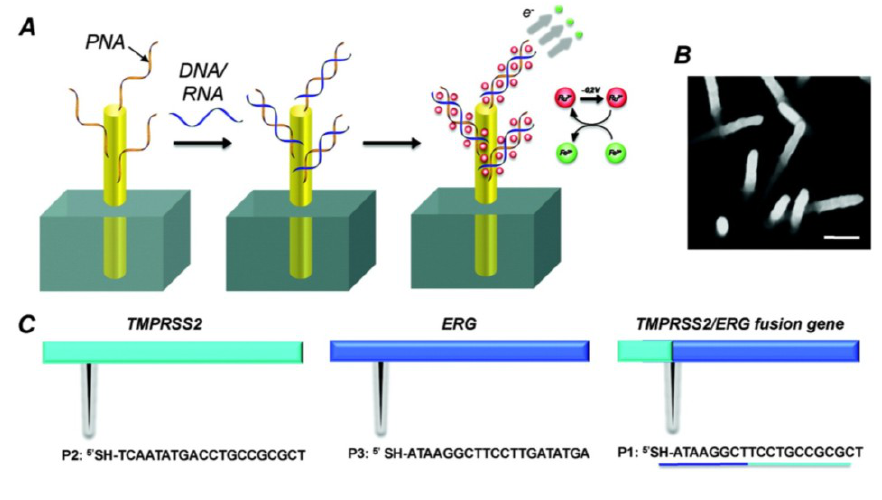
Figure 10. ( A ) Schematic illustration of electrocatalytic detection of nucleic acids using nanowire sensors; ( B ) Representative scanning electron micrograph (SEM) of gold nanowires used in this Study; and ( C ) Sequences of probes complementary to TMPRSS2 (P2), ERG (P3), or the TMPRSS2:ERG fusion (P1). Reprinted with permission from [70]. Copyright 2009 American Chemical